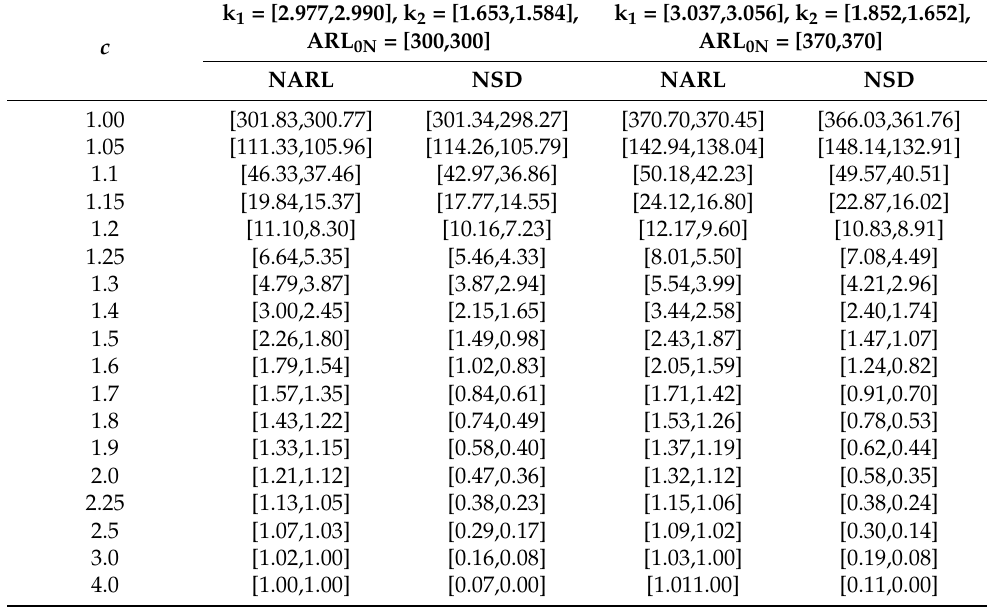
Table 6. The NARL when n N (cid:101) [8,10] and I λ U =